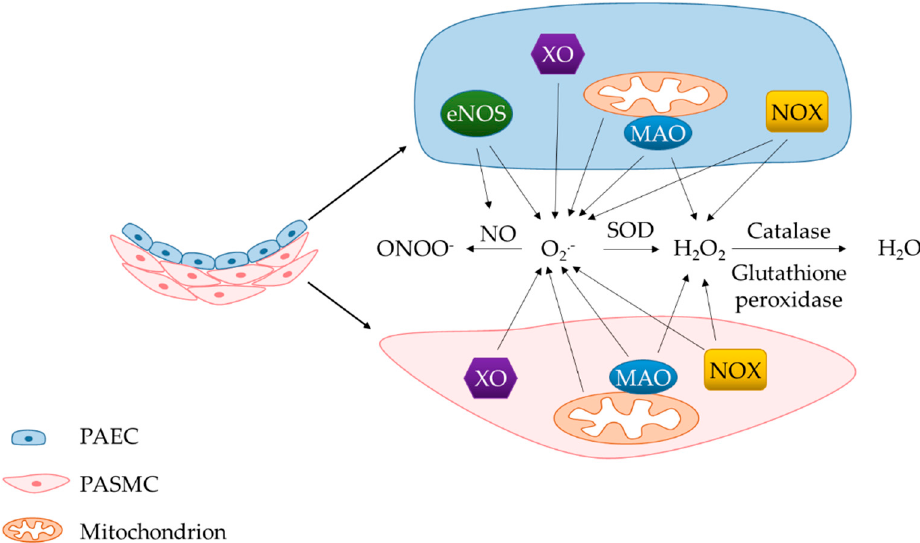
Figure 2. O 2. − is generated from various enzymatic sources and converted to other forms of ROS, including H 2 O 2 and ONOO − . H 2 O 2 can also be produced from NOX4 and MAOs. PAEC, pulmonary arterial endothelial cell; PASMC, pulmonary arterial smooth muscle cell; ROS, reactive oxygen species; O 2. − , superoxide; H 2 O 2 , hydrogen peroxide; ONOO − , peroxynitrite; H 2 O, water; NOX, NADPH oxidase; eNOS, endothelial nitric oxide synthase; XO, xanthine oxidase; MAO, monoamine oxidase; SOD, superoxide dismutase.